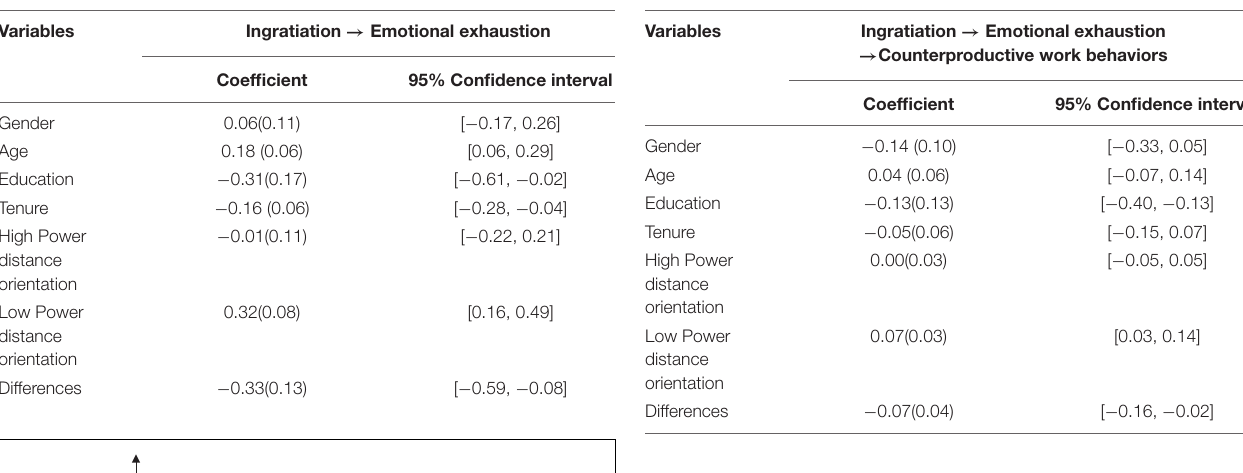
TABLE 5 | Results of moderation effect analysis.